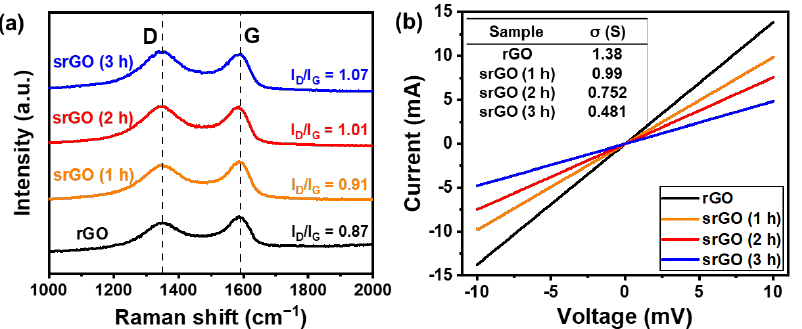
Figure 3. ( a ) Raman spectra and ( b ) representative IV curves of rGO, srGO (1 h), srGO (2 h), and srGO (3 h).